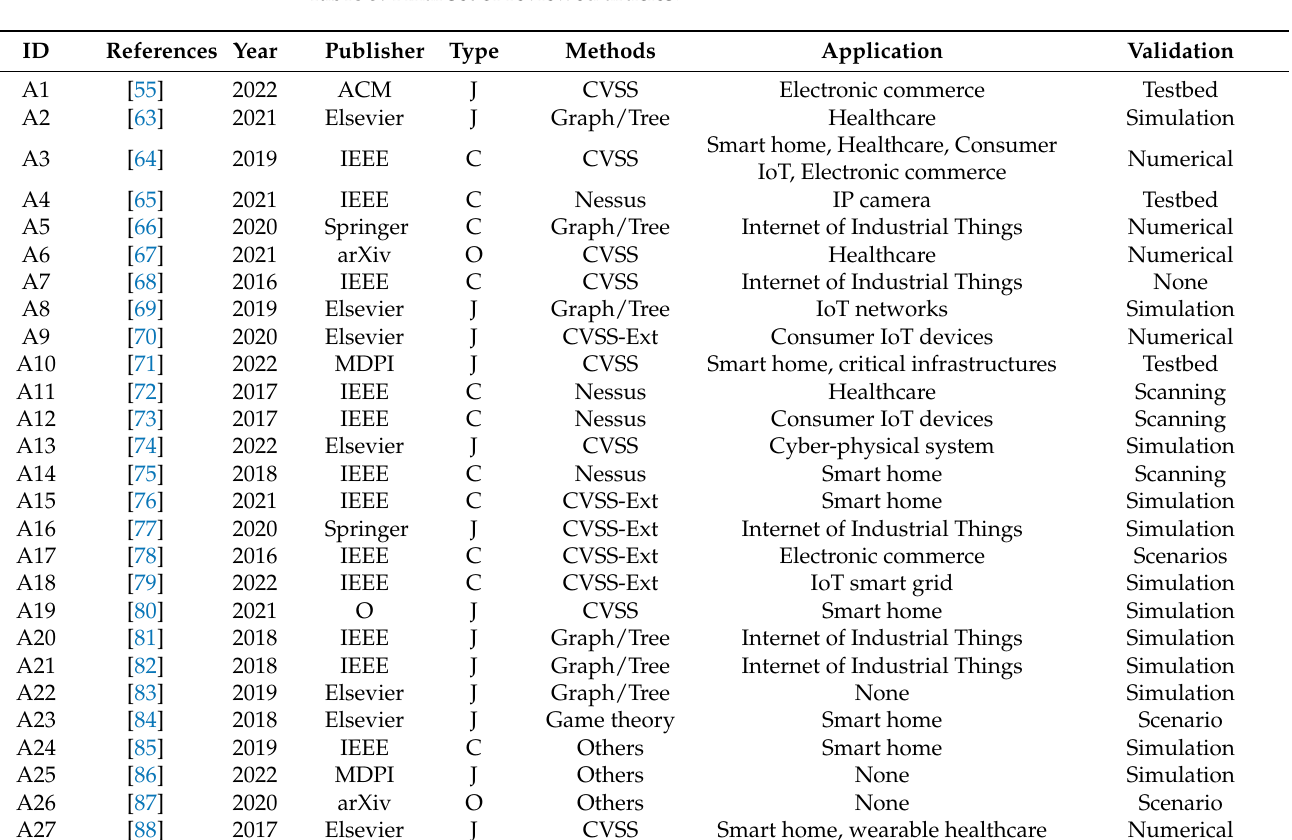
Table 5. Final set of reviewed